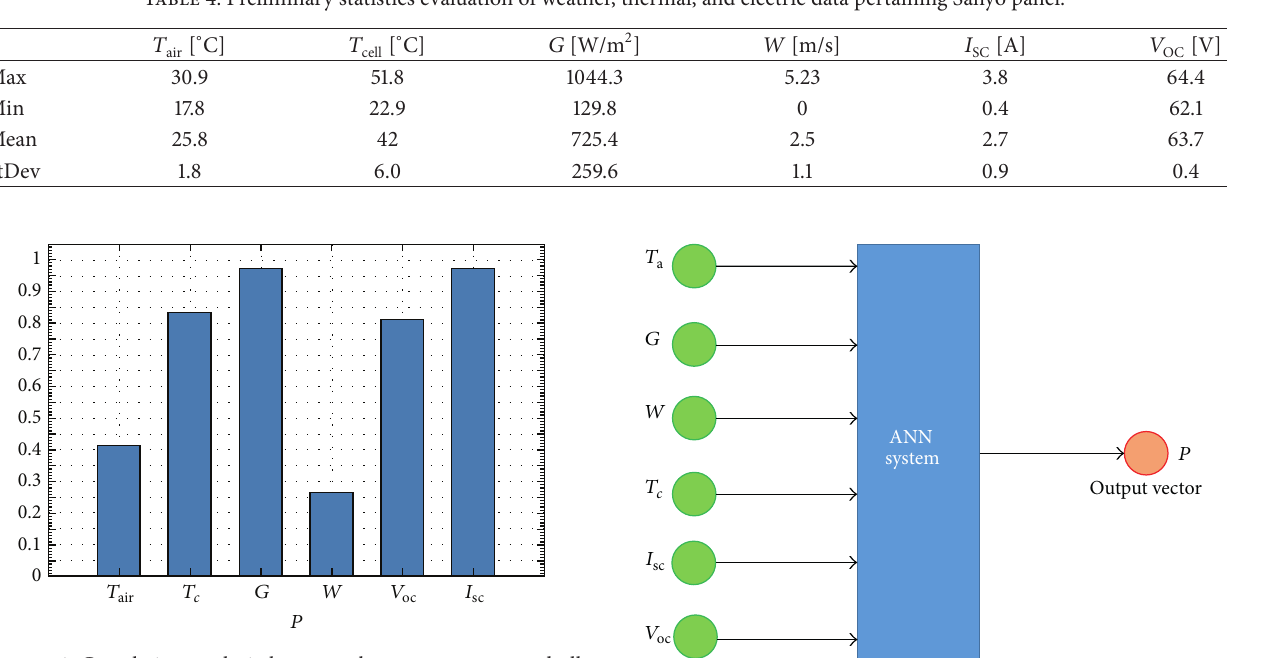
Figure 6: Correlation analysis between the power output and all input data of the Kyocera panel.